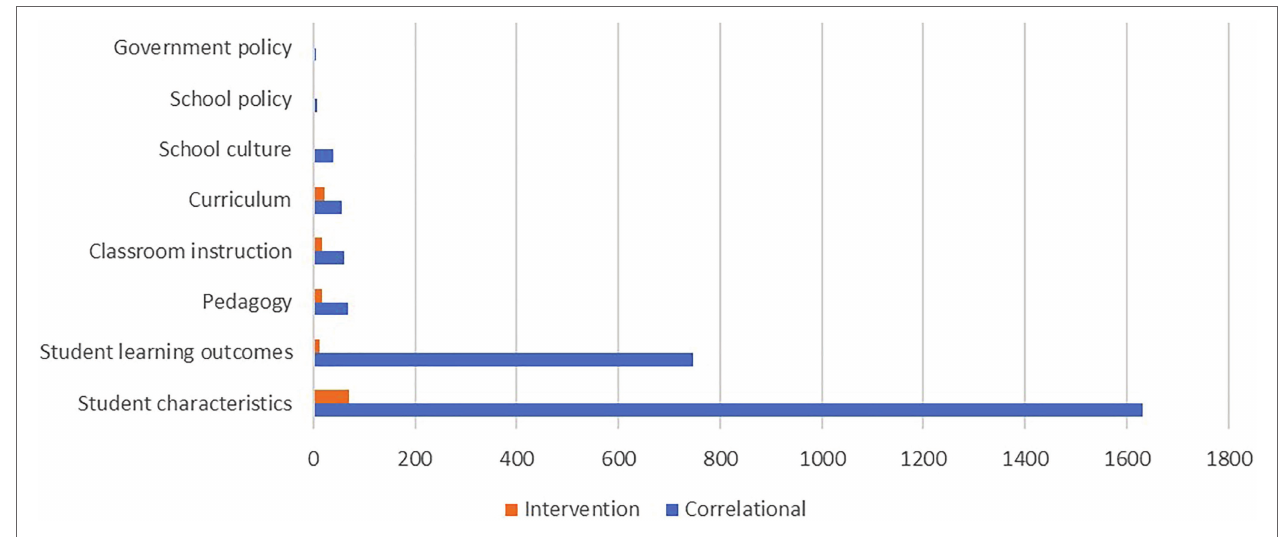
FIGURE 5 | Focus of positive education quantitative